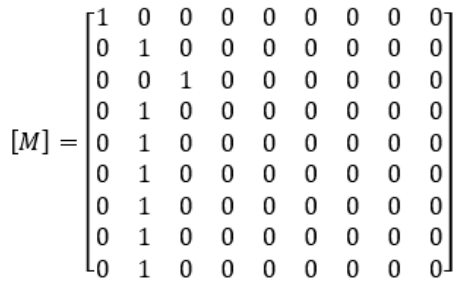
Figure 3. Maintenance matrix.